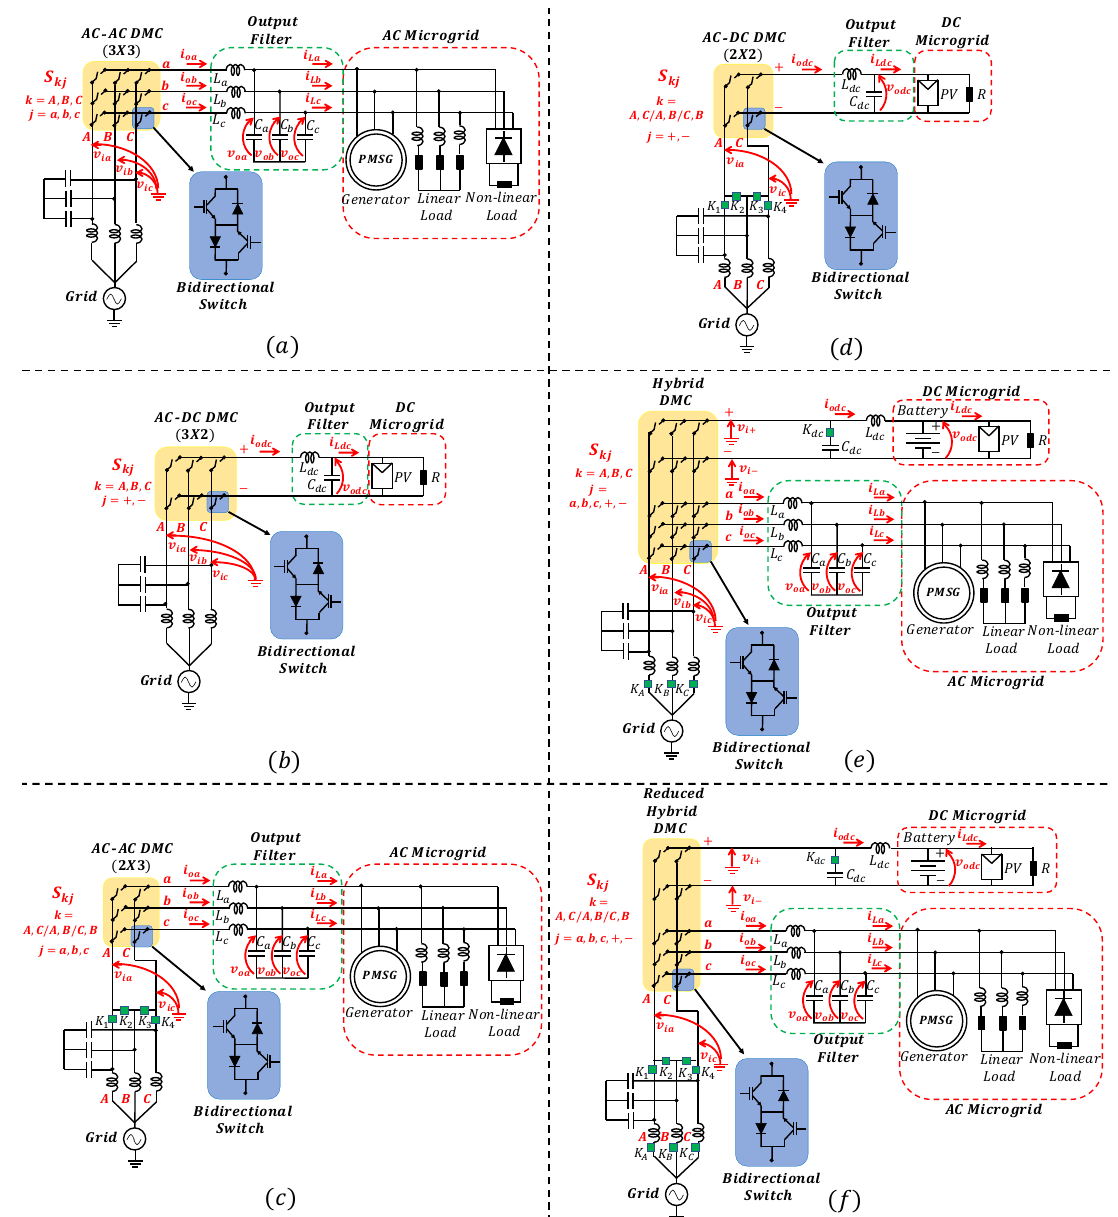
Figure 1. DMC topologies. ( a ) AC-AC 3 × 3, ( b ) AC-DC 3 × 2, ( c ) AC-AC 2 × 3, ( d ) AC-DC 2 × 2, ( e ) hybrid DMC, and ( f ) reduced hybrid